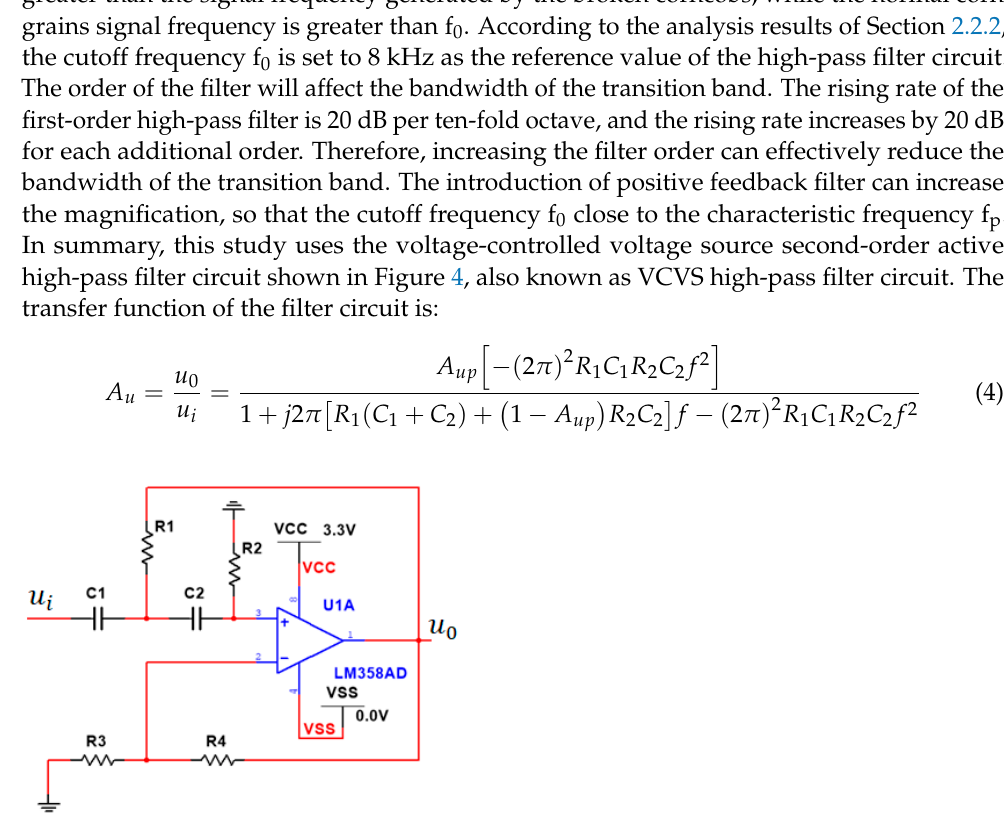
Figure 4. Second order active high-pass filter circuit of voltage controlled voltage source.